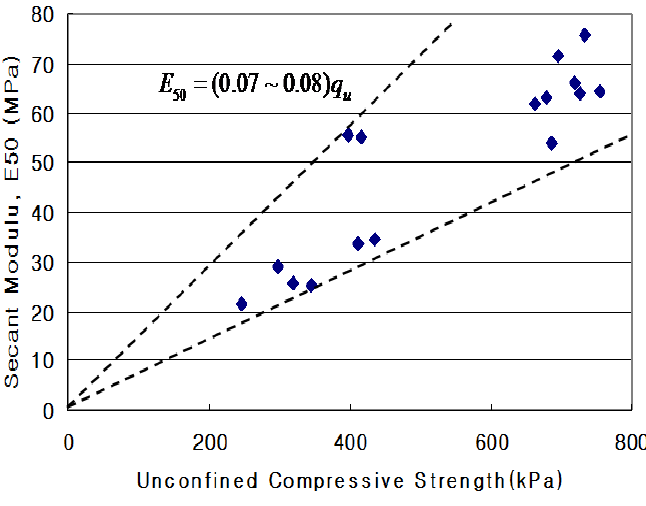
) and secant modulus ( E u